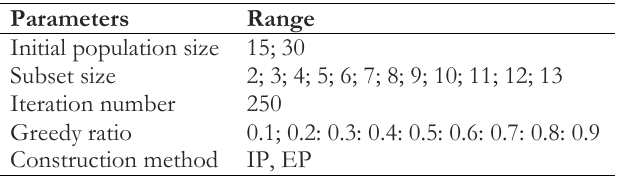
Table 1. The parameters and range.